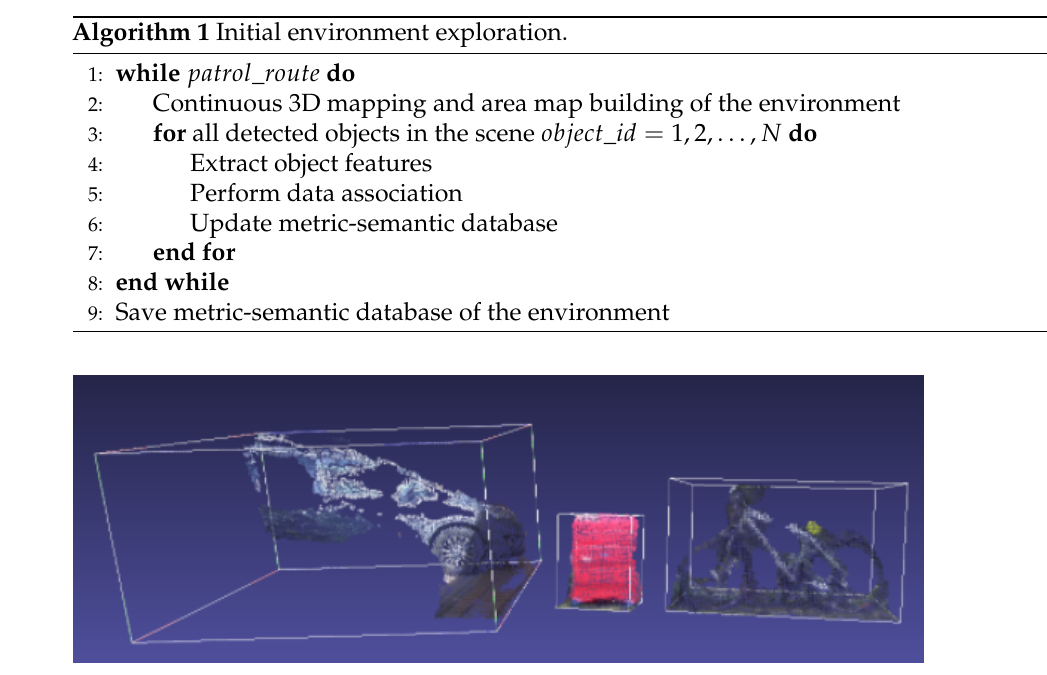
Figure 4. Example of 3D segmented point clouds of three objects: a car, suitcase and